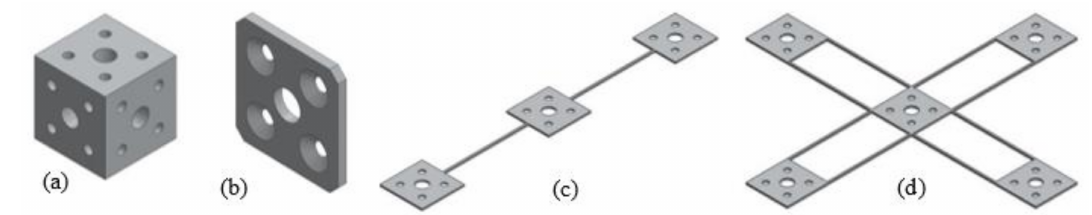
Figure 13. Main assembling components: ( a ) rigid cube; ( b ) rigid washer; ( c ) compliant passive compliant modules (PM) beam; and ( d ) compliant AM beam.